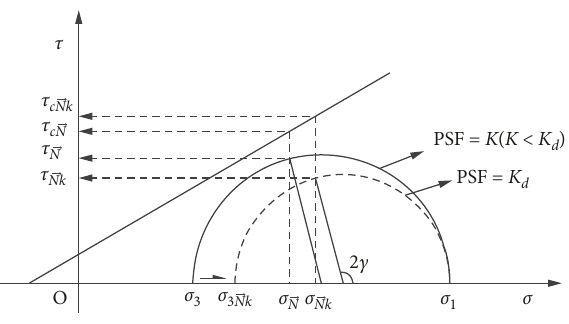
Figure 1: Schematic diagram of definition for